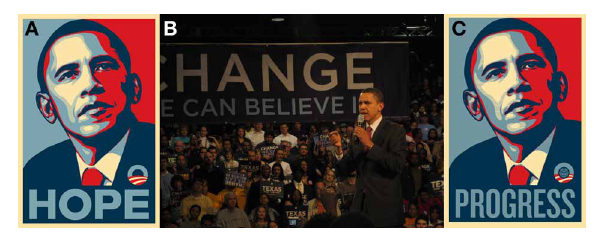
FIGURE 1 | Sample media from Barack Obama’s 2008 US presidential campaign. The visual pairing of Barack Obama’s face with highly positive words was ubiquitous during the campaign and may have contributed to the observed change in US participants’ valence associations with black faces. There is an interesting similarity between the face-word pairings used in the campaign posters and the positive word trials in the ALPS measure of implicit bias. (A) Campaign poster presenting the face of Barack Obama above “HOPE” (which has a positive word rating score of 7.05, where 0 = most negative, and 9 = most positive—as measured by the ANEW corpus); (B) Barack Obama next to “CHANGE” (ANEW does not have a rating for “Change”); (C) Barack Obama’s face above “PROGRESS” (which has a positive word rating score of 7.73). (A,C) Are Barack Obama 2008 campaign posters created by Rhode Island artist Shepard Fairey < http://obeygiant.com/ > . (B ) Is in the public domain and was provided via